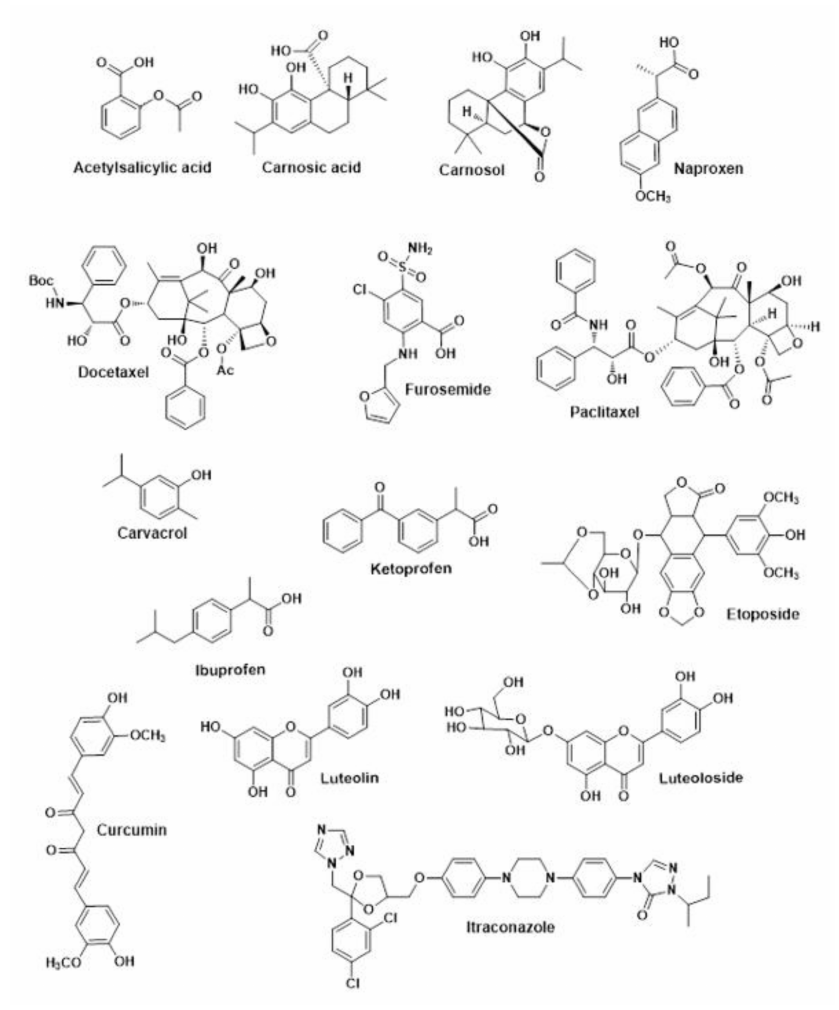
Figure 5. Molecular structures [114,175,176] of model liposoluble compounds that have been used as encapsulated bioactive molecules in studies using MCC, CNC, and CNF as carriers for the delivery of liposoluble